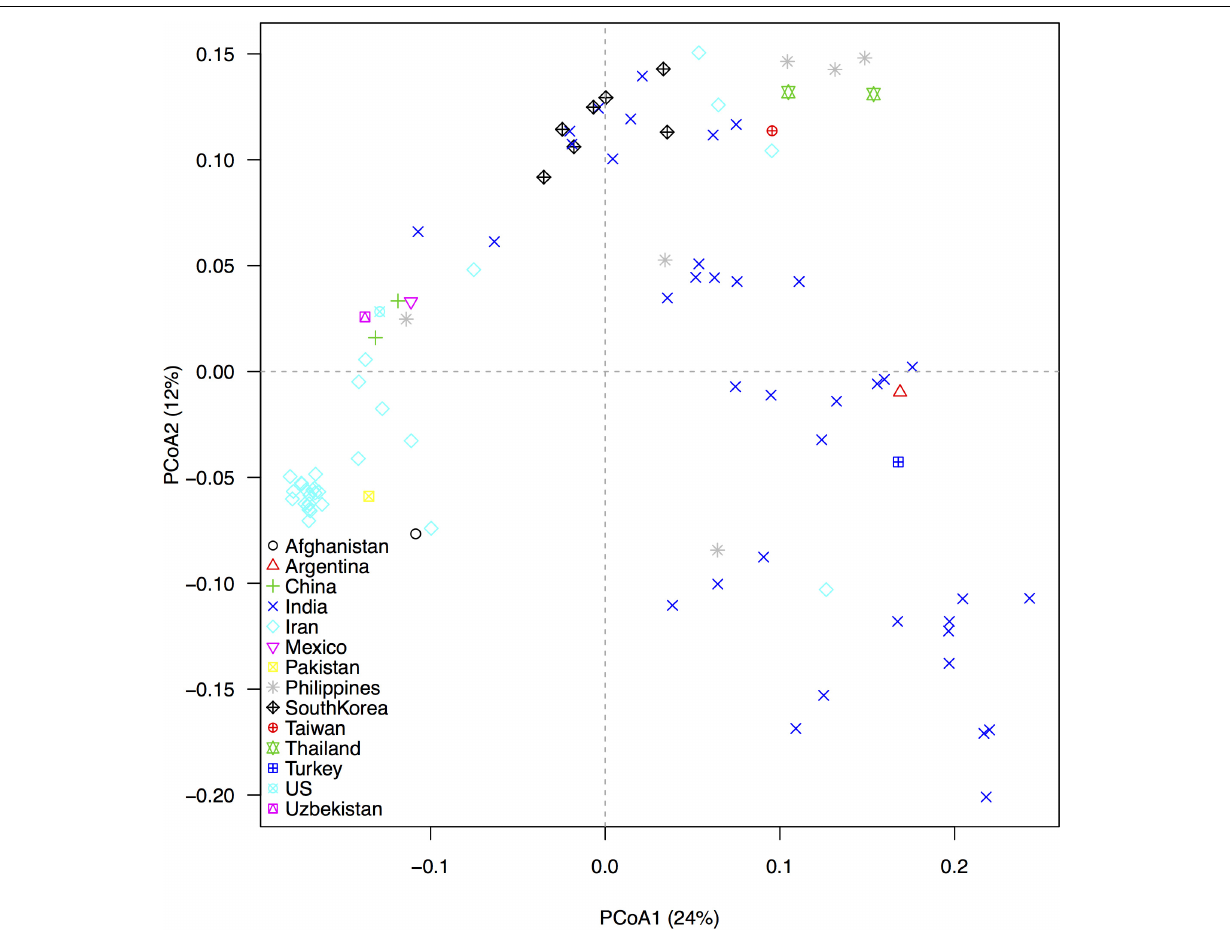
FIGURE 3 | Genetic associations between 95 mung bean ( Vigna radiata ) accessions from the USDA core collection based on 6,486 SNP markers developed from Genotyping by Sequencing (GBS), as revealed by a principal coordinate analysis (PCoA). Different colored symbols identify the country of origin of each accession. The percentage of variation explained by each axis is shown within parenthesis in the label of the corresponding